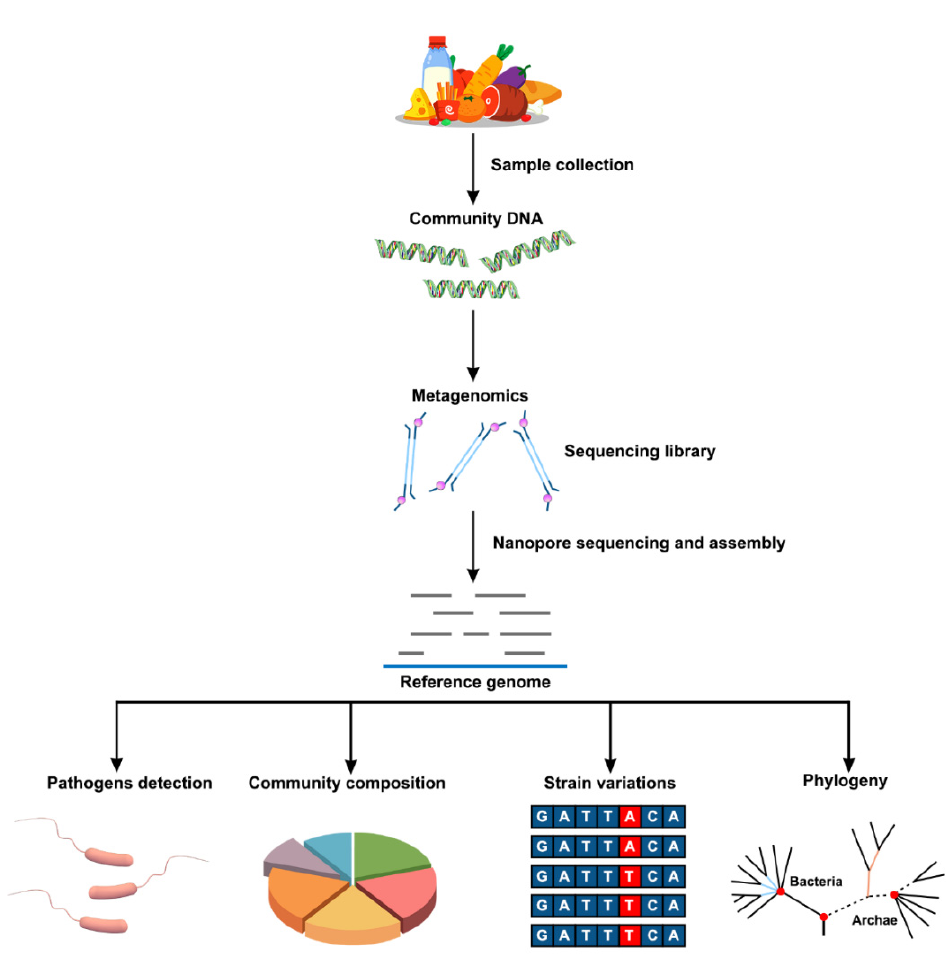
Figure 3. Schematic flow chart of the metagenomic analysis of food samples using nanopore se- quencing. After collecting samples from food, total DNA is extracted to obtain community DNA. Subsequently, motor proteins and linkers are added to the resulting DNA to construct a library. In ad- dition, an appropriate library construction kit can be selected to improve the accuracy of sequencing.